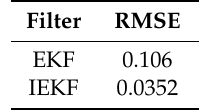
Figure 1. Comparison of EKF and IEKF over a sinusoidal signal. Table 2. Estimation Errors.